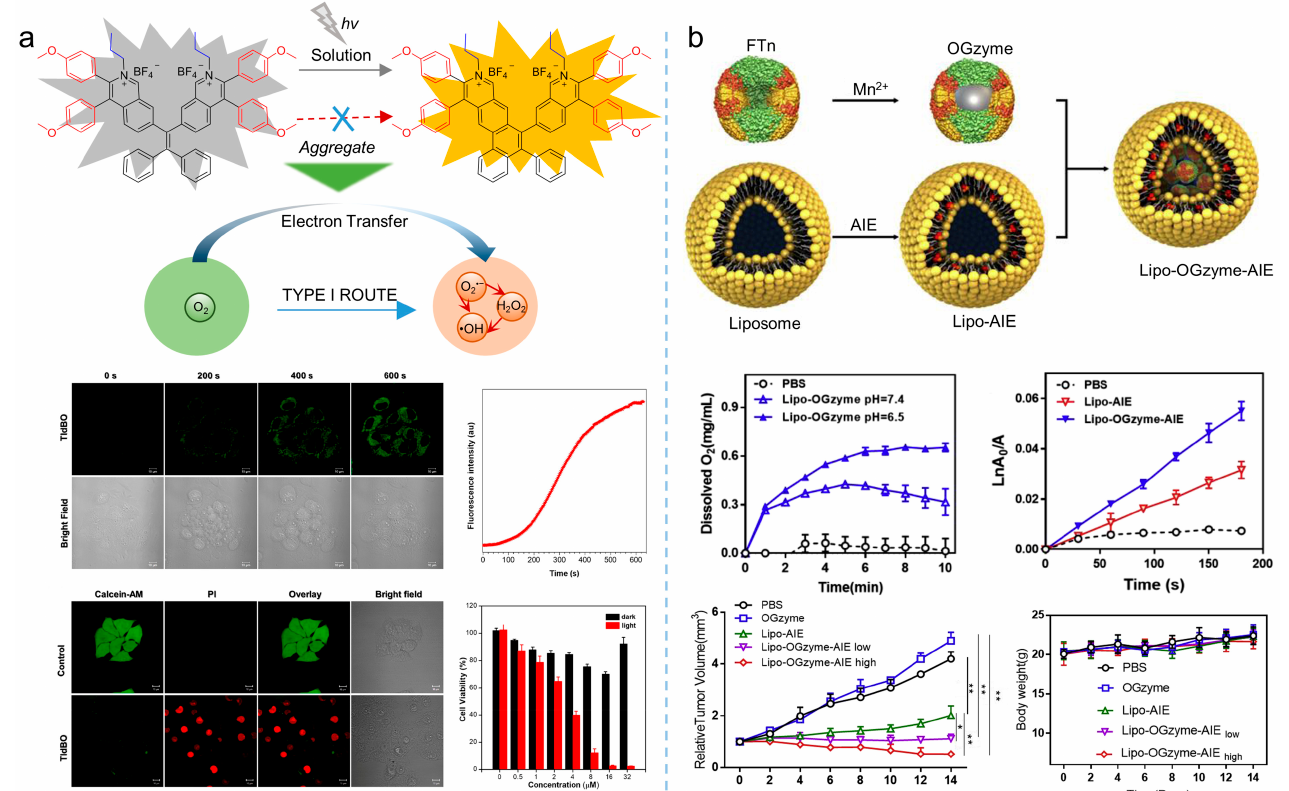
Figure 16. Type I ROS or self-oxygenated strategies to enhance theranostics. ( a ) Schematic illustra- tion of producing type I ROS utilizing the electron transfer during the photoactivation process and theranostics effects of type I photosensitizers. Reprinted with the permission of the authors of